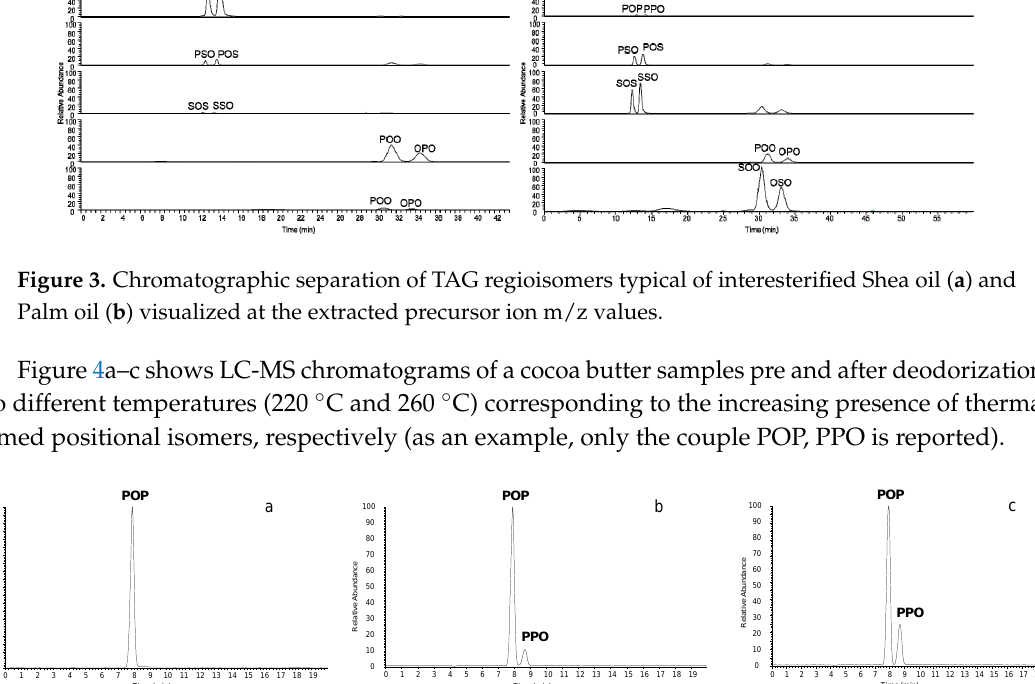
Table 2. Comparison of TAG (triglyceride) percent composition between original raw materials and confectionery final products (biscuit filling cream).